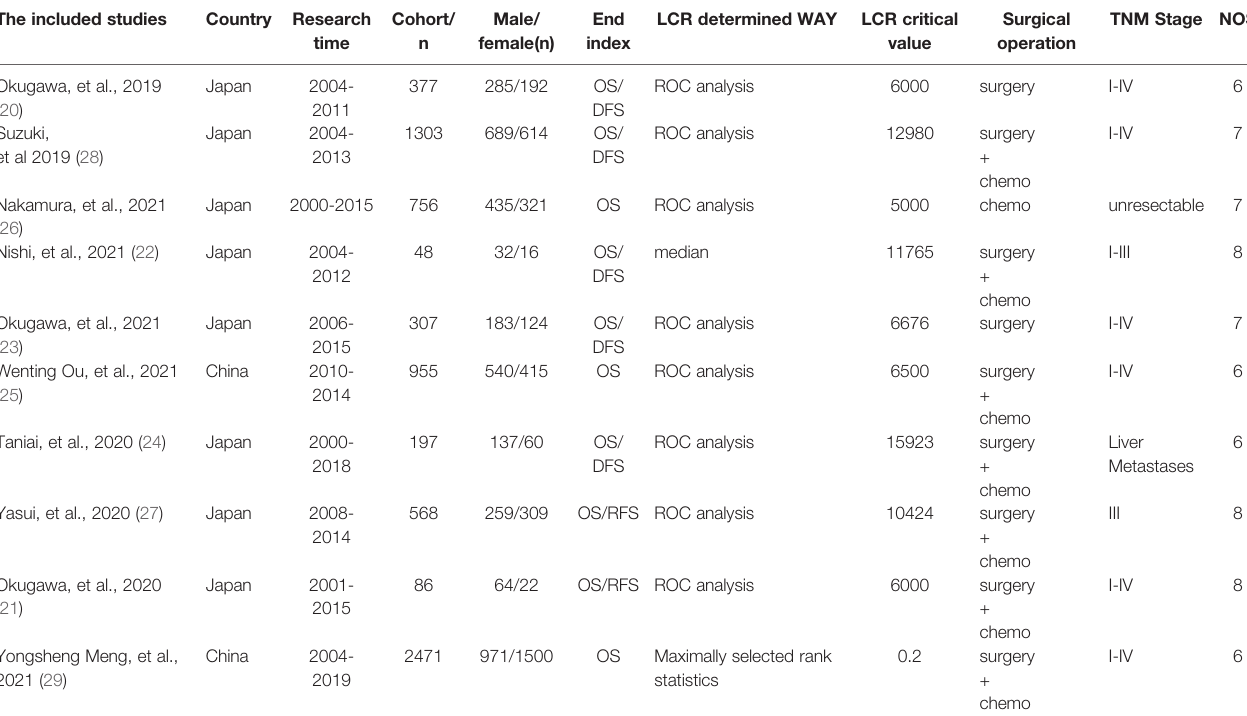
TABLE 1 | Characteristics of included